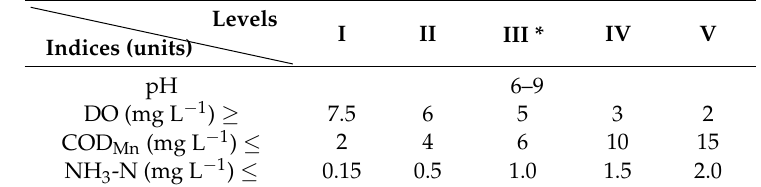
Table 2. Water quality levels and standard limits of pH, DO, COD Mn , and NH 3 –N from Environmental Quality Standards for Surface Water in China (No.